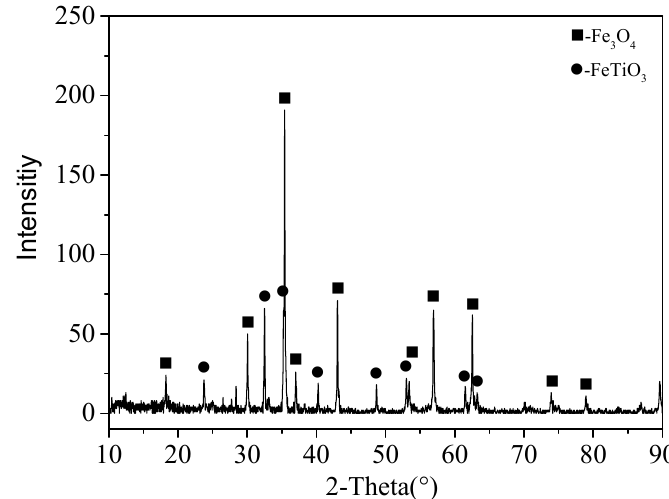
Figure 1. XRD of the VTMCs.